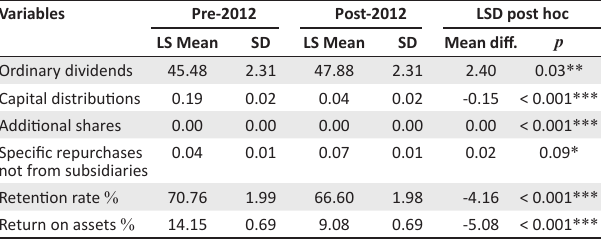
TABLE 5: Fisher’s least significant difference post hoc